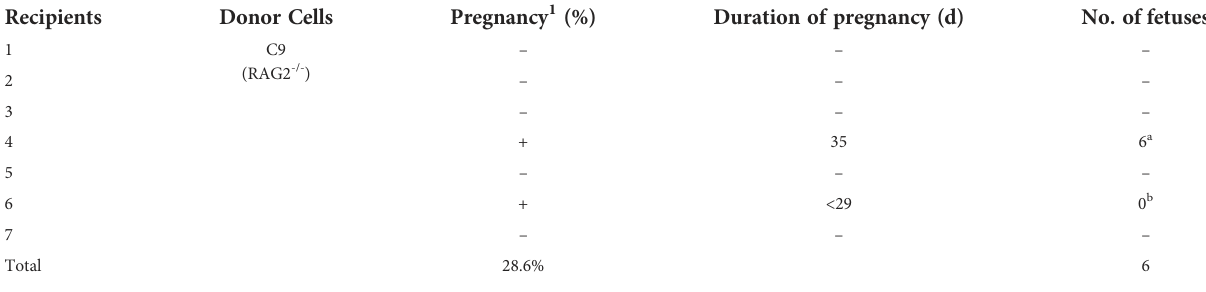
TABLE 1 Summary of the generation of RAG2 -/- fetuses by somatic cell nuclear transfer. Recipients